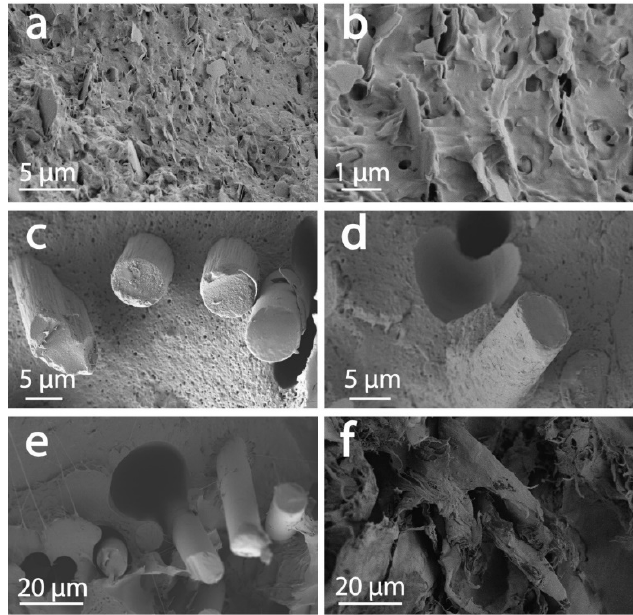
Figure 9. Magnified fractured surfaces as obtained after tensile tests highlighting polymer-additive interfaces observed by SEM for ( a,b ) Udiam-PLA, ( c,d ) CF-PET, ( e ) GF-PA6 and ( f ) UPM Formi-PLA.